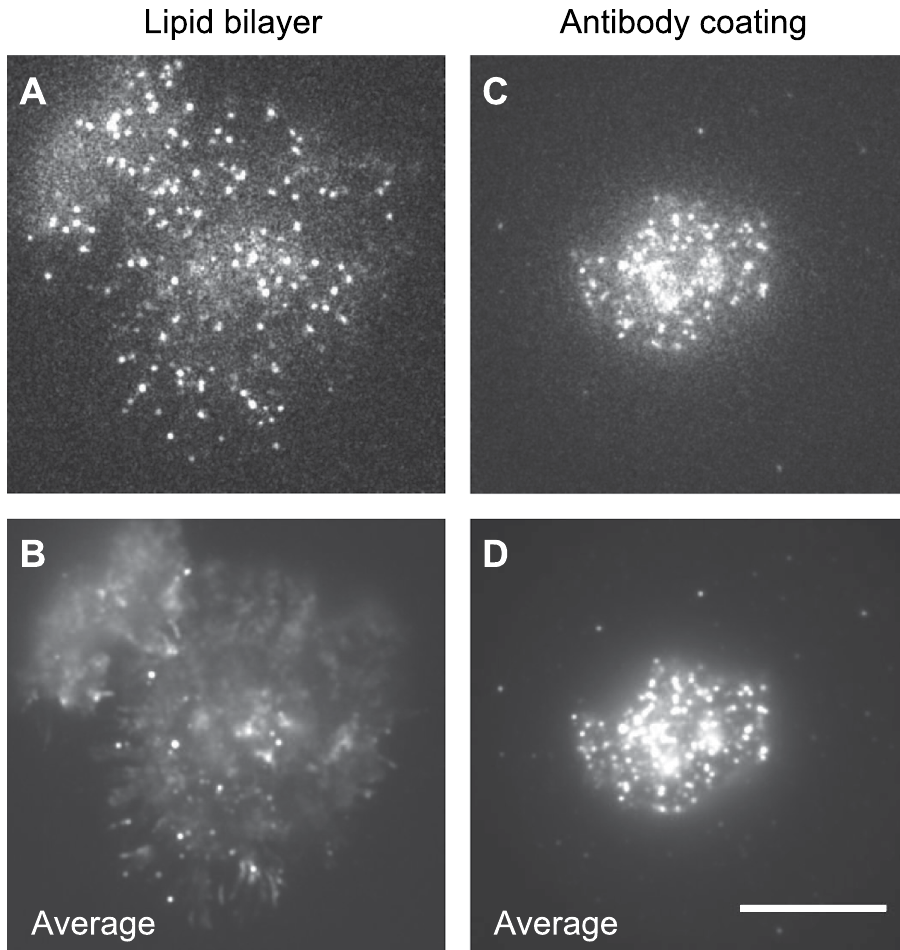
Figure 2. Usage of planar lipid bilayers for examination of molecular mobility in living cells. Single-molecule images of Qdot 585-labeled CD45 in living Jurkat cells on a lipid bilayer ( A,B ) and on an antibody-coated glass surface ( C,D ). Single-frame images ( A,C ) and 200-frame averaged images ( B,D ) recorded at 33 ms/frame are shown. The difference between single-frame images and multi-frame averaged images indicates high molecular mobility. Bar, 10 μ